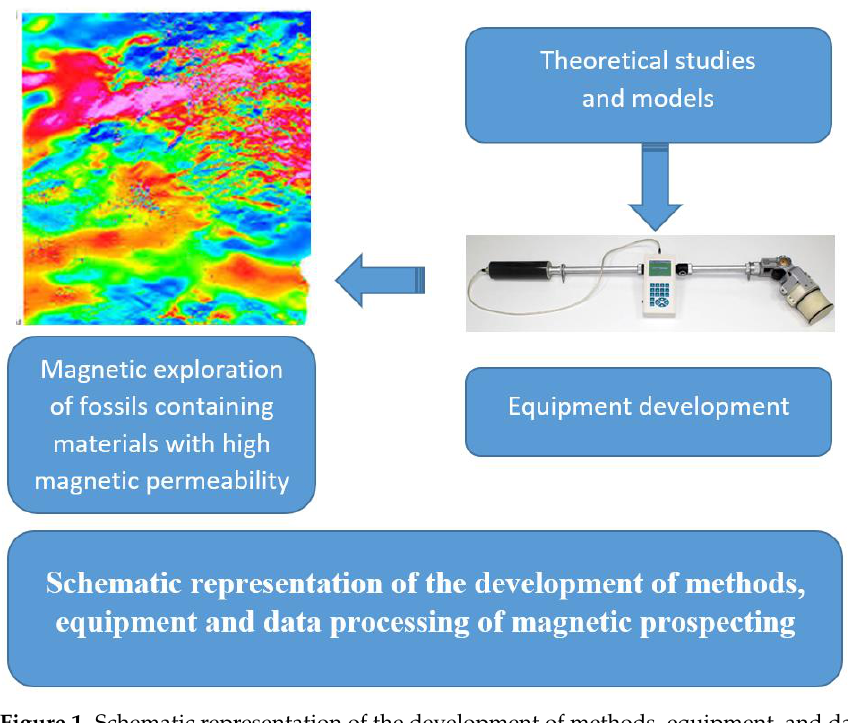
Figure 1. Schematic representation of the development of methods, equipment, and data processing of magnetic